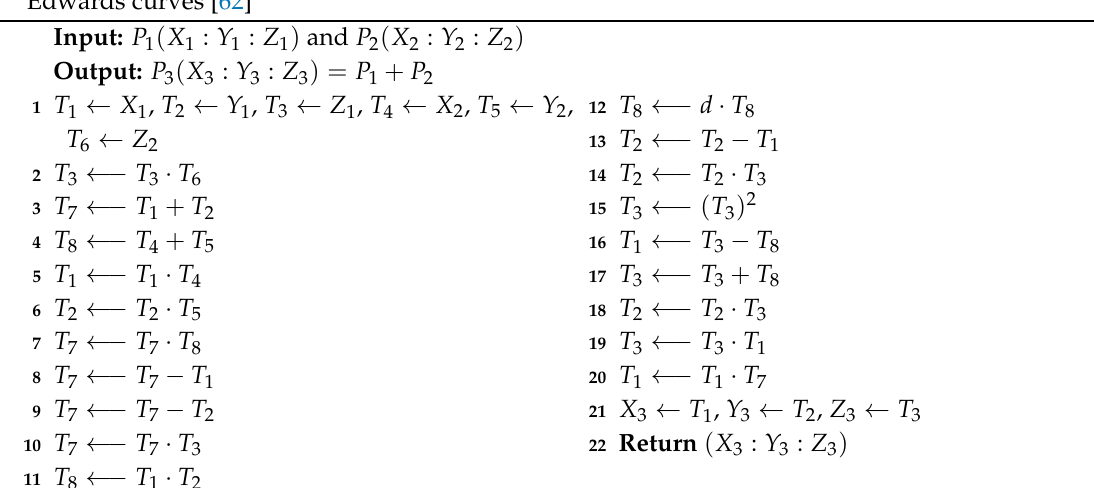
Algorithm 3: Elliptic curve point addition in projective coordinates over prime fields using Edwards curves